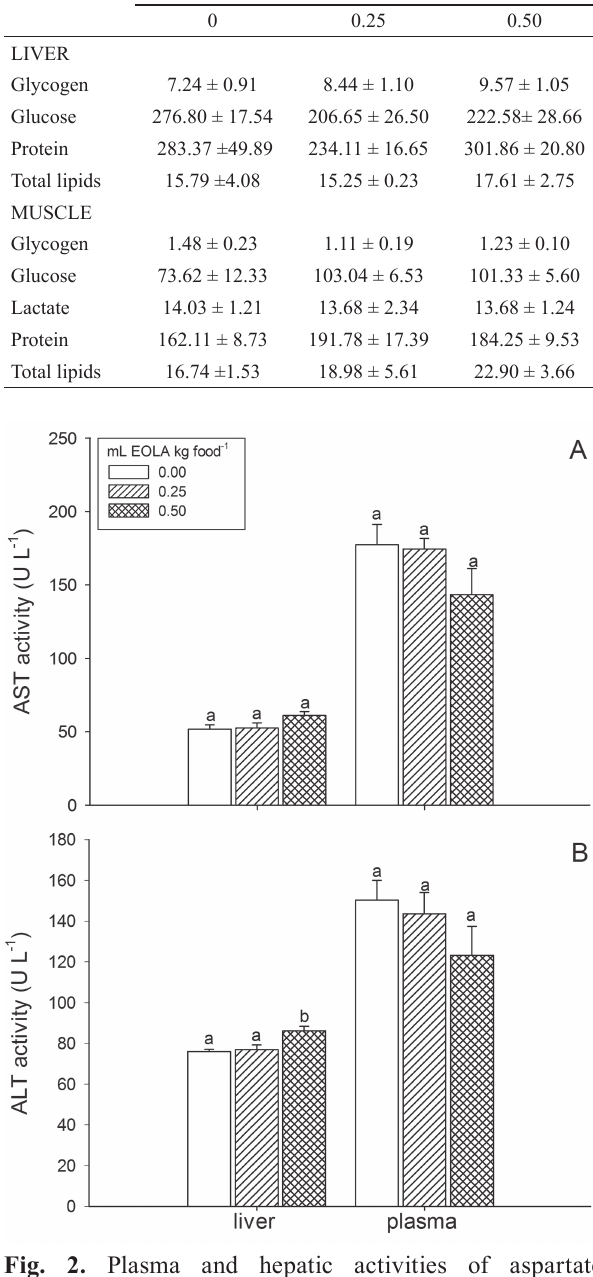
Fig. 1. Plasma lactate (A), glucose (B) and cortisol (C) of Rhamdia quelen fed with different concentrations of dietary essential oil of Lippia alba (EOLA). Mean ± SEM. Different letters indicate significant differences (P < 0.05) between treatments.